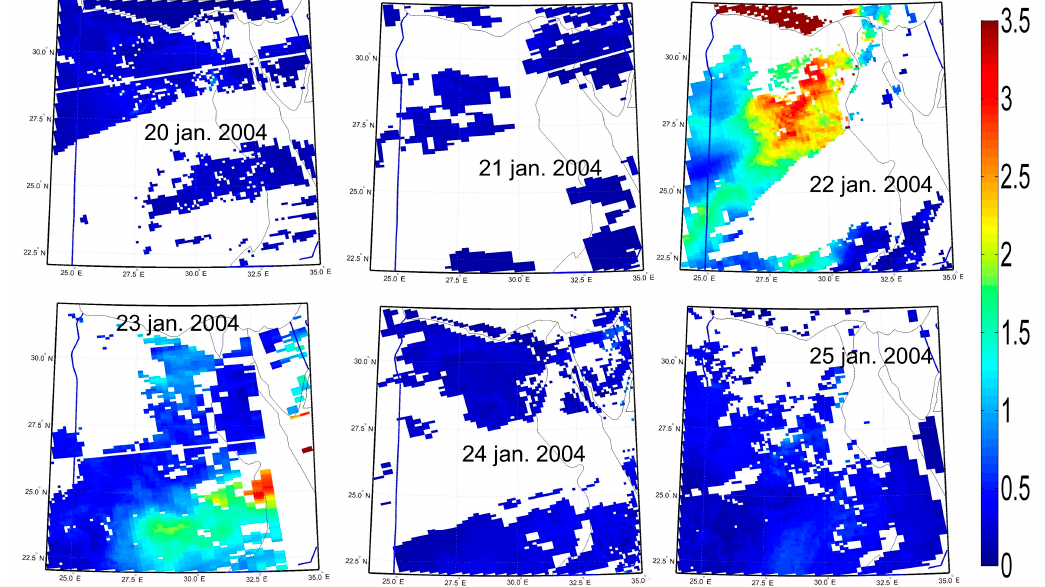
Figure 4. Maps of AOD at 550 nm from MODIS over Egypt on 22–25 January 2004 corresponding to the highest observed SAPE event (Figure 2). High values of AOD in the western desert area are apparent on 22 and 23 January, suggesting emissions and transport of desert dust. White areas represent pixels with no data.